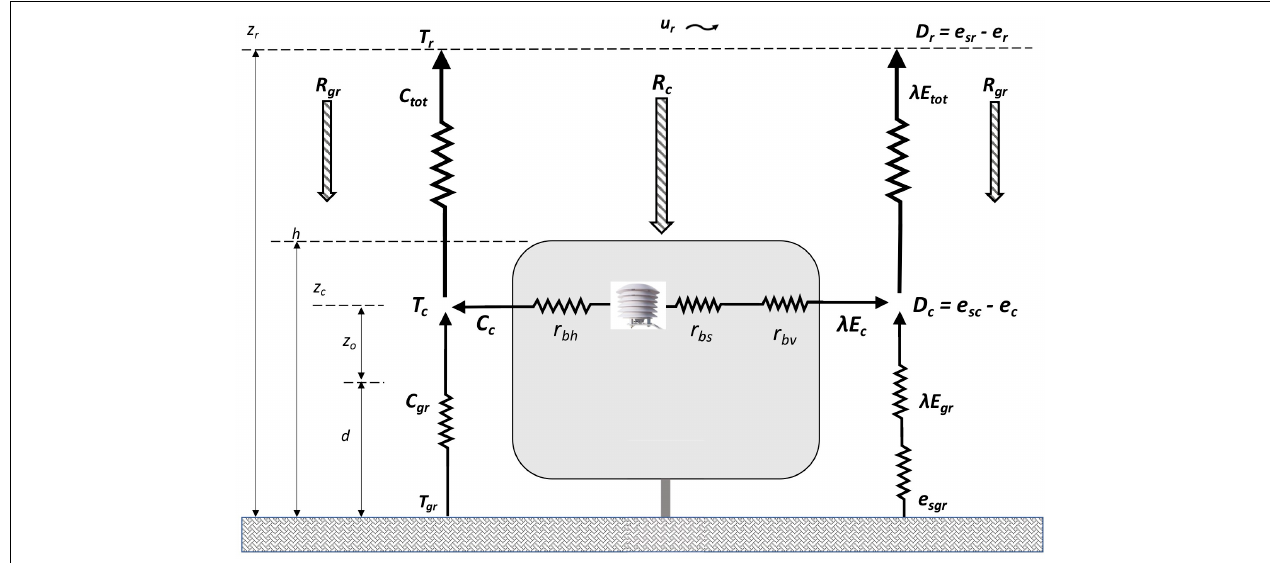
FIGURE 1 | Schematic of convective and radiative heat fluxes to and from the vine canopy and surrounding ground based on Shuttleworth and Wallace, 1985; Lhomme et al.,